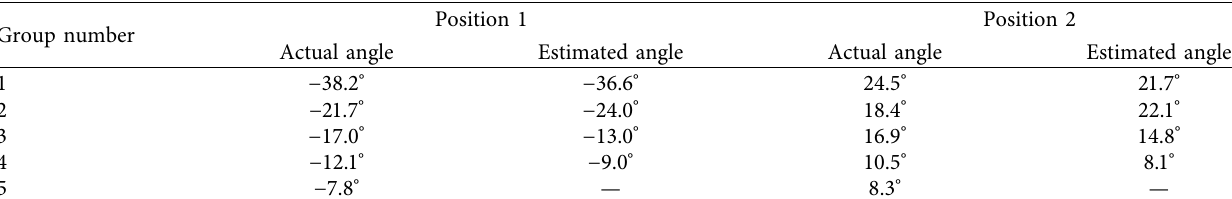
Figure 18: DOA estimation of two LoRa signal sources. Table 3: The results of DOA estimation.